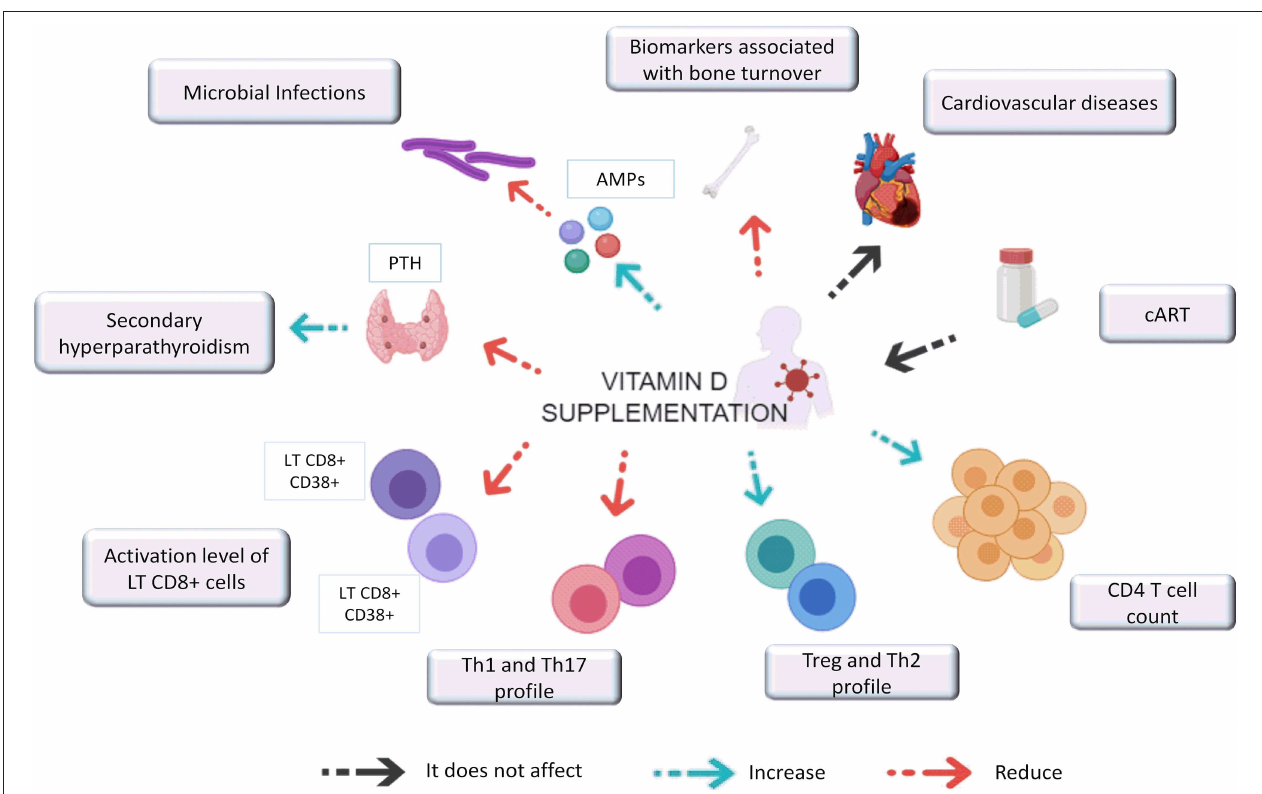
FIGURE 1 | Effect of vitamin D supplementation on clinical and immunological aspects associated with HIV-1 infection. VitD supplementation in HIV-1 infected individuals reduces PTH levels that promotes secondary hyperparathyroidism. It also induces the expression of AMPs (antimicrobial peptides) such as CAMP and HBD and improve bone formation while decrease biomarkers associated with bone turnover. VitD supplementation seems not impact CVD, and the VitD repletion success did not depend on the cART regimen. In addition, supplementation with this hormone seems also to increases CD4T cell count, promoting their differentiation toward a Th2 and Treg profile while decreasing the Th1 and Th17 profiles and the activation levels of CD8 + T